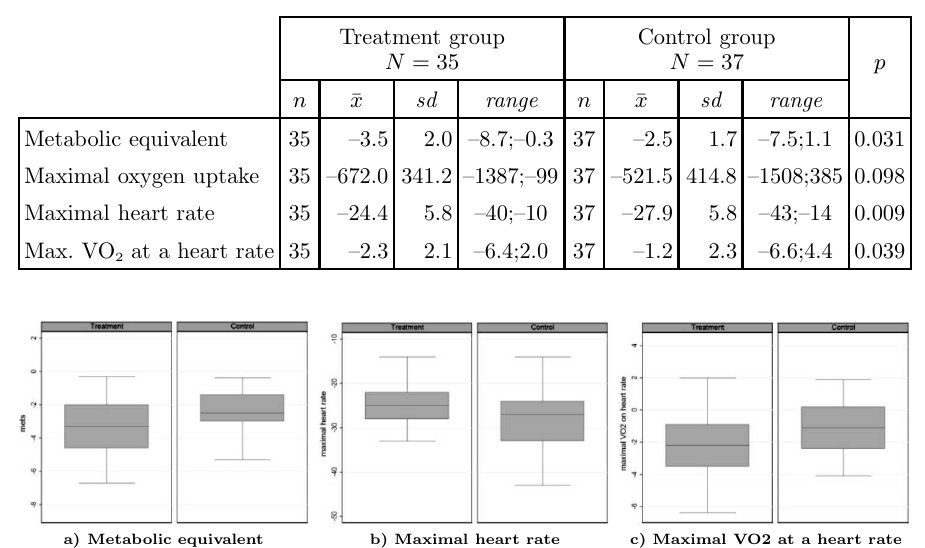
Table 1. Comparisons between the treatment group and the control group for cardiovascular parameters